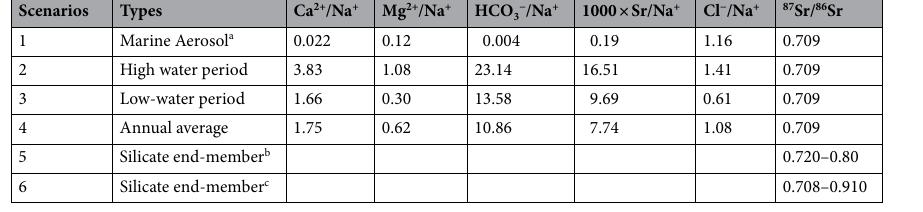
Table 2. Inverse model sensitivity tests. a,b Millot et al. 47. c Moon et al. 40 .